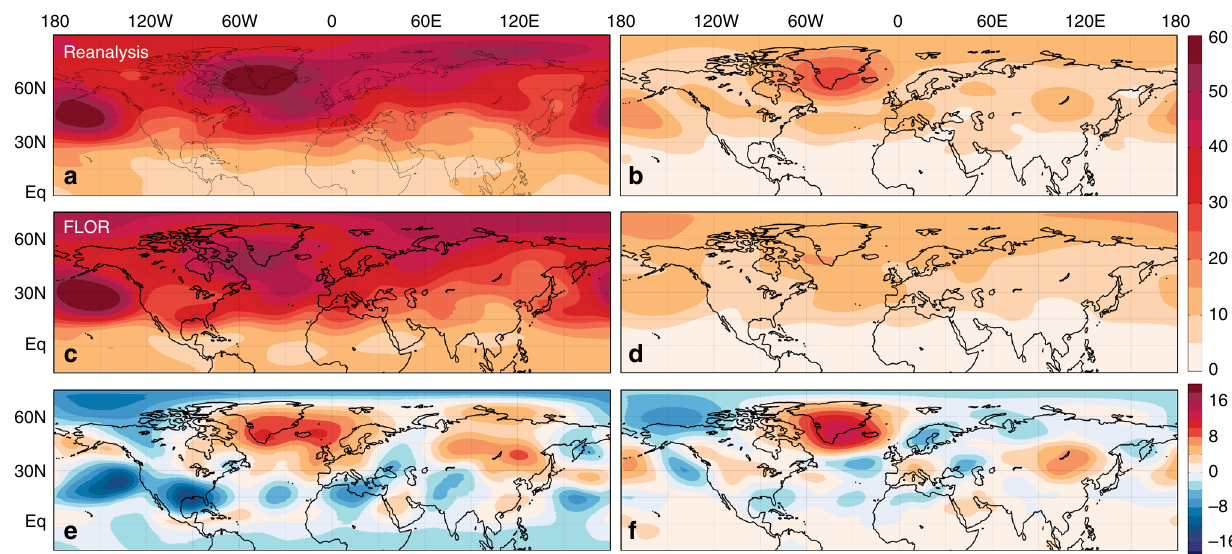
Fig. 5 Standard deviations of wintertime geopotential height in reanalysis and in FLOR. Standard deviations ( m ) of linearly detrended December – March 500 hPa geopotential height in NCEP/NCAR reanalysis data ( a ) and the 500-yr FLOR simulation ( c ). b , d Same as a and c but for 13-yr running mean 500 hPa geopotential height data. e Difference between reanalysis and FLOR standard deviations ( a minus c ). f Same as e but for 13-yr running mean data